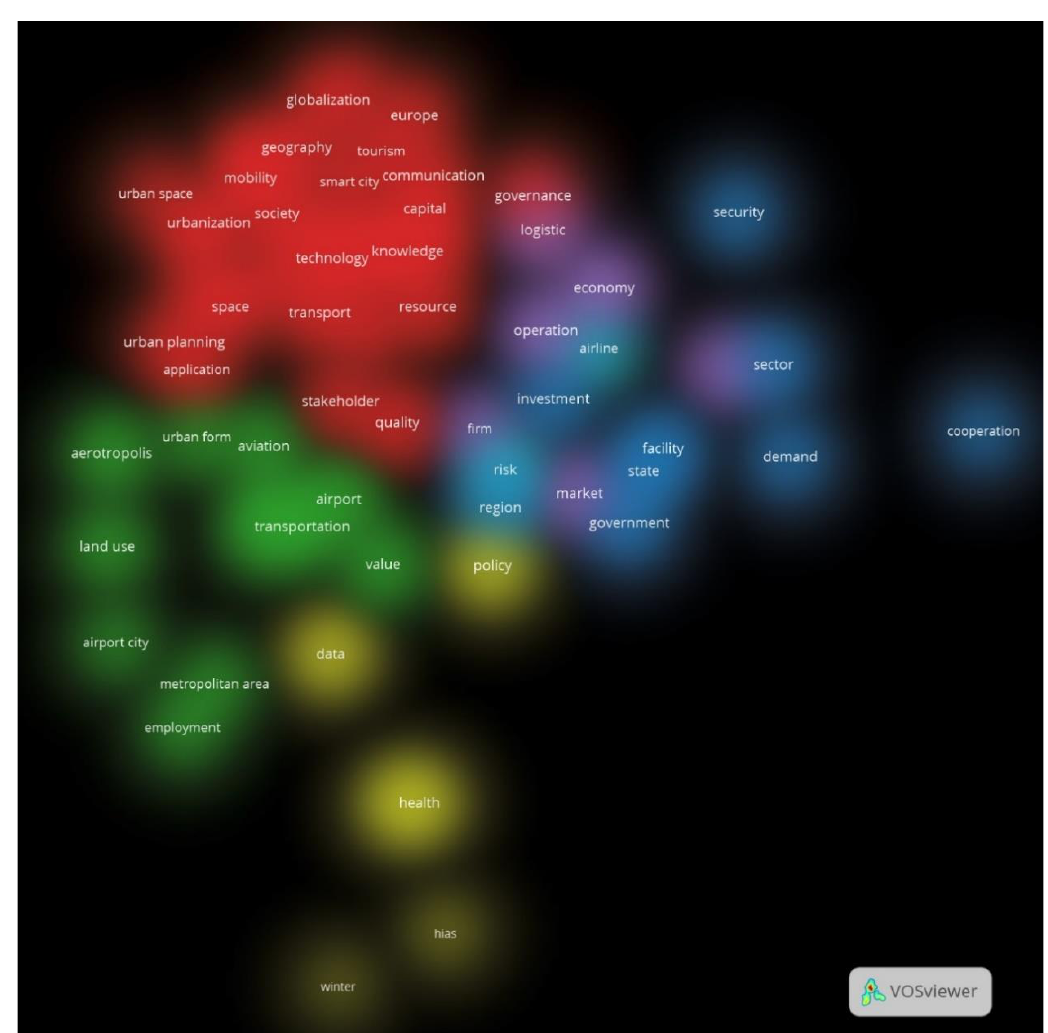
Figure 14 . Distribution by Keyword Occurrence index . Figure 14. Distribution by Keyword Occurrence